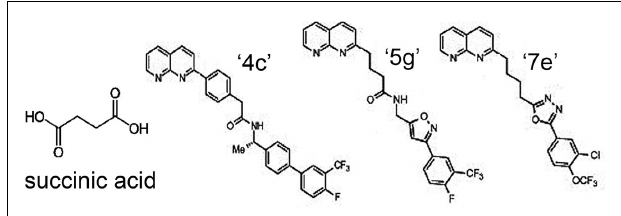
FIGURE 4 | Structure of SUCNR1 ligands. From left to right: succinic acid, compound “4g,” compound “5g,” and compound “7e.” Structures were derived from (Bhuniya et al.,